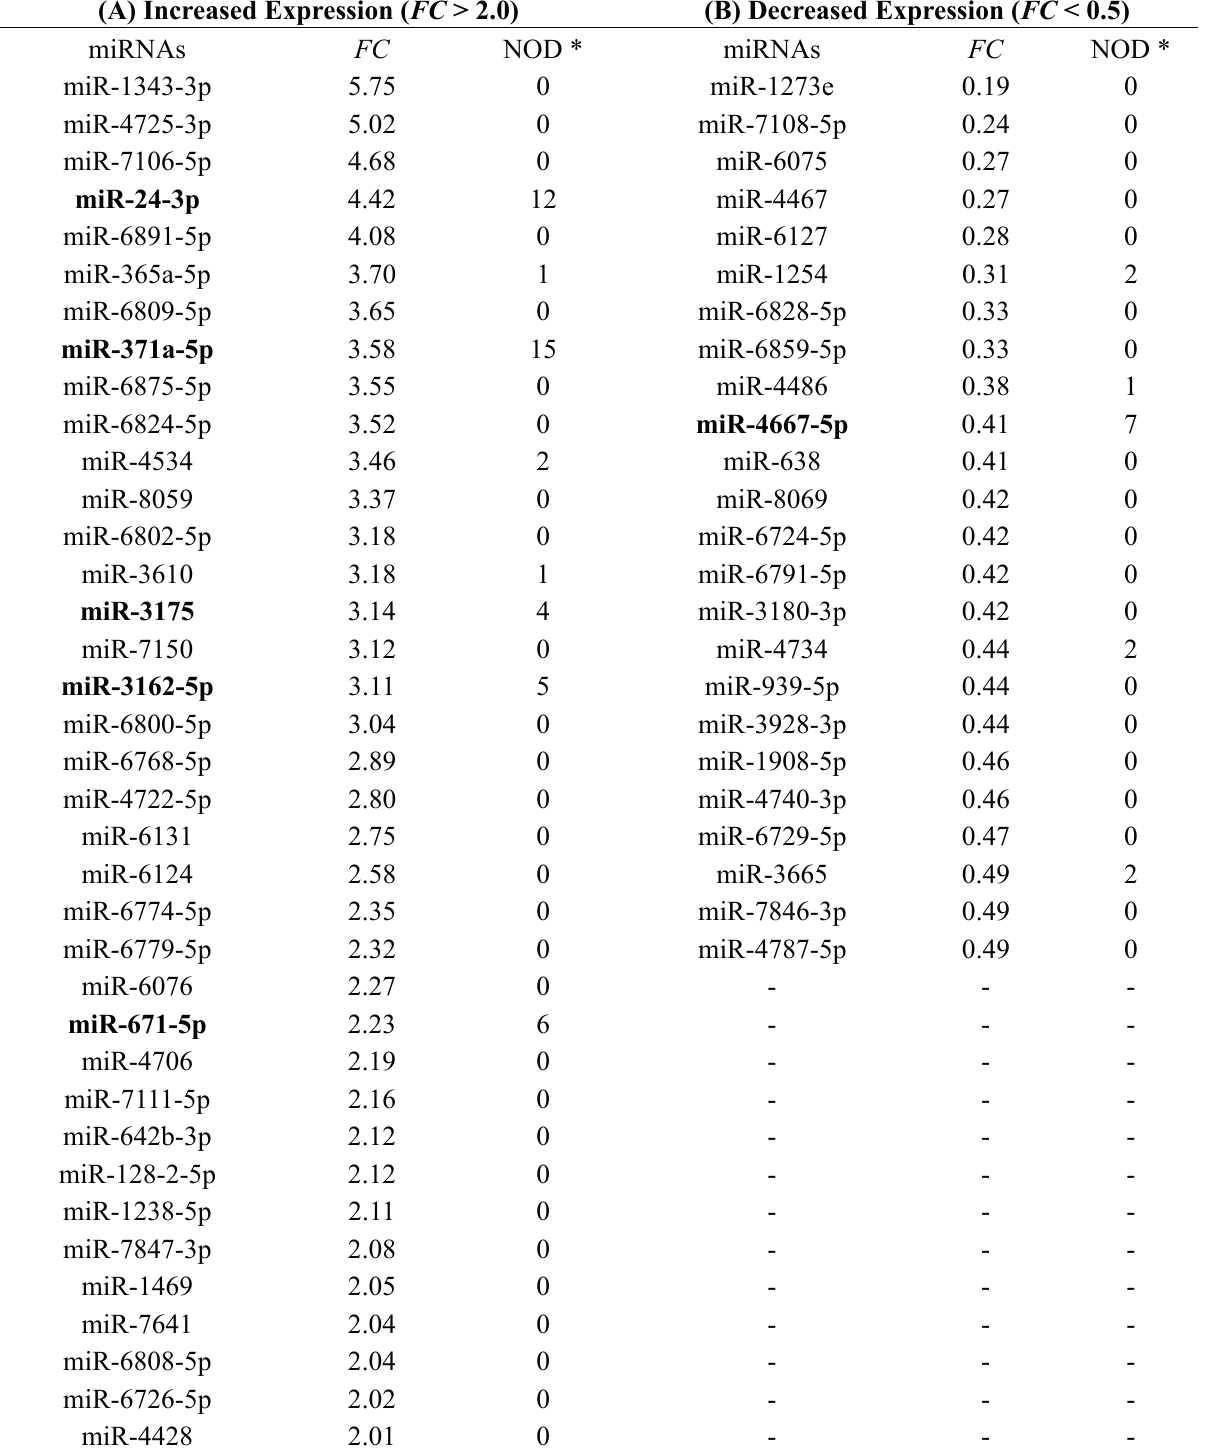
* NOD represents modified novel out degree that calculated by using commonly detected miRNAs and age-related pathways; FC : fold change of miRNAs for old group using young group as reference. The miRNAs with ≥ 4 NOD (novel out degree) are represented in